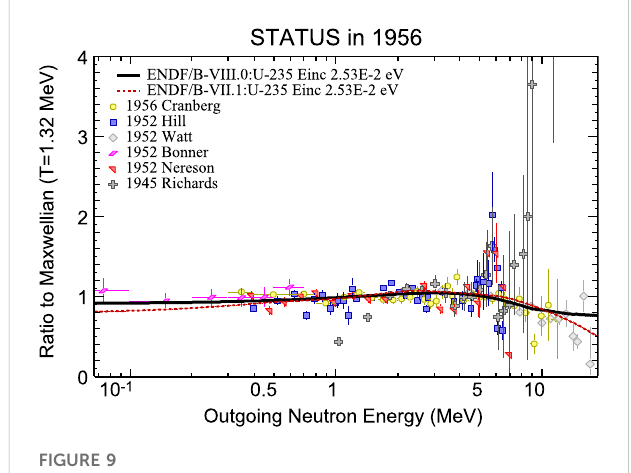
Figure 7 shows these 235 U Staub and Nicodemus Los Alamos 1944 data as solid red points. They are in fair agreement with the previous Stanford measurement by Bloch and Staub (grey diamond symbols), and with some, but not all, of Richards ’ Minnesota measurements. The Staub and Nicodemus measurements also agree fairly well with ENDF/B-VIII.0 today (an evaluation at 1.5 MeV), black curve. Recent LANSCE data are shown for comparison: the 2020 high- accuracy